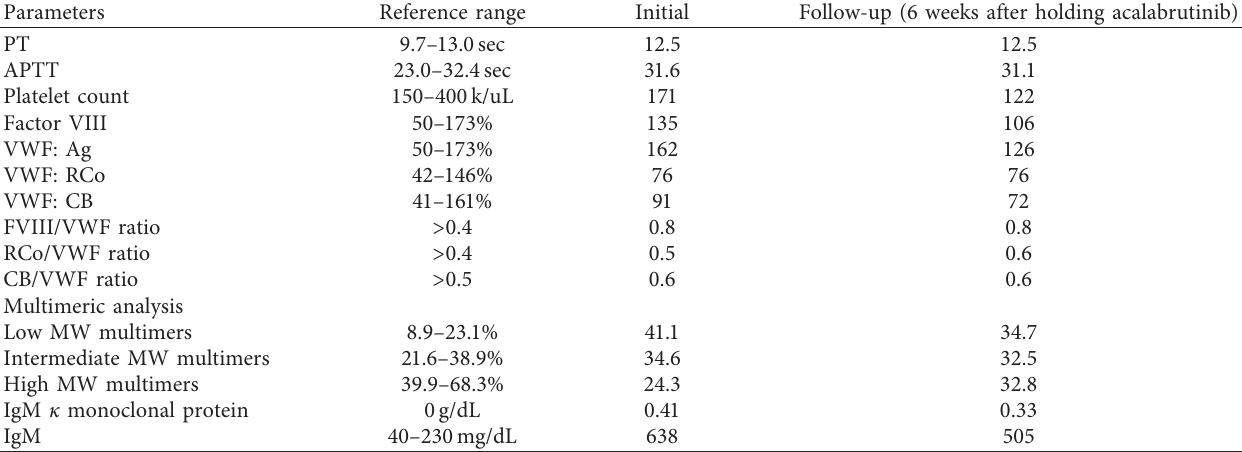
Table 2: Coagulation parameters of patient 1 in the setting of acalabrutinib-related subungual hematoma.